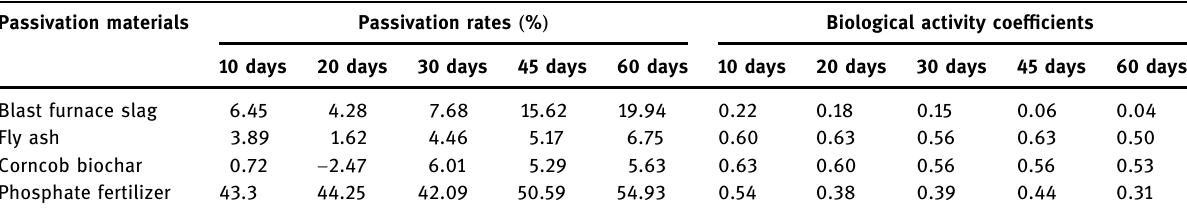
Table 3: Passivation rates and biological activity coe ffi cients during passivation process Passivation materials Passivation rates ( %